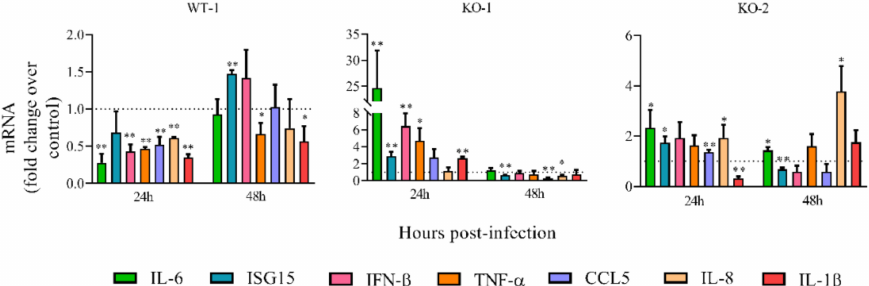
Figure 4. Relative mRNA levels of inflammatory / antiviral genes in A20 knockout (KO) cells. Cells were infected at a MOI of 3. Levels of mRNAs were quantified by qRT-PCR at 24 and 48 hpi and represented as fold-over mRNAs expressed in infected A549 parental cells. Data are represented as the mean and standard deviation from three independent experiments. Pairwise comparisons between each cell type and parental A549 cells (control) were done for each gene and time post-infection by using the t -test. From the p values obtained, FDRs were calculated: *, q-value < 0.05 and **, q-value < 0.01. KO-1 and KO-2, A549 cell lines that do not express A20. WT-1, wild-type A549 cell line obtained following the same process as with KO-1 and KO-2. Fold change = 1 means that there is no expression change with respect to the control (A549 cells) and is represented by a dotted